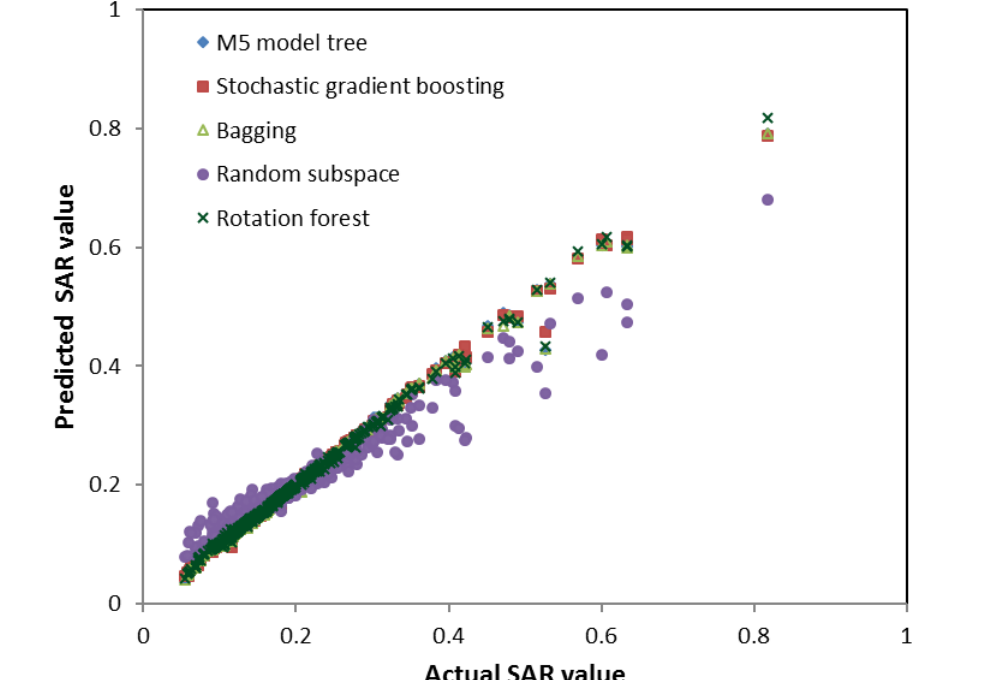
Figure 3. Actual vs. predicated SAR value by different ensemble approaches using M5 model tree and four input